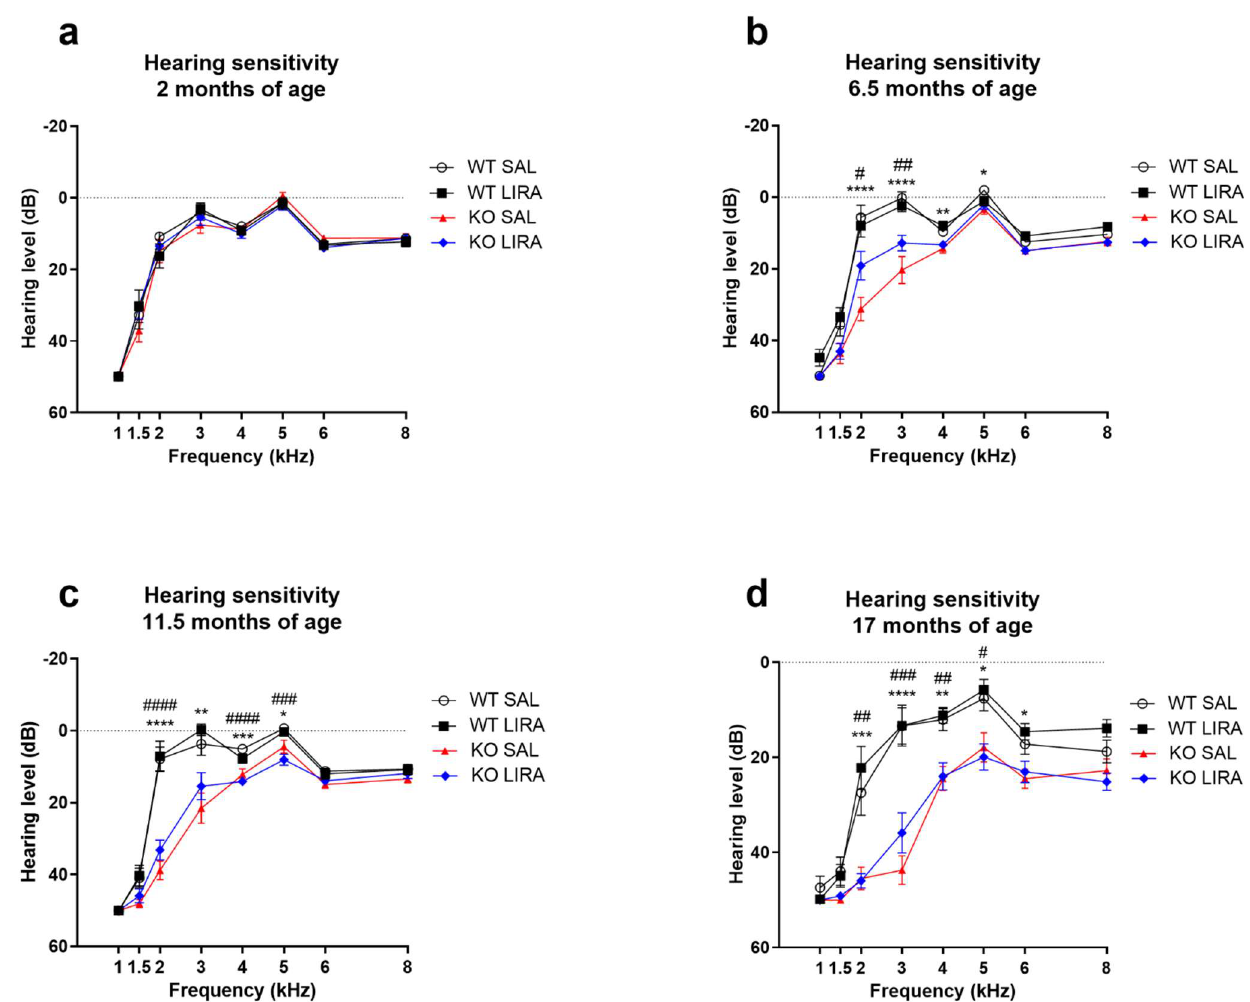
Figure 3. At the age of 6.5 months, hearing sensitivity of Wfs1 KO rats starts to decline in the range of 2 to 4 kHz and liraglutide treatment delays the decline of hearing sensitivity. Hearing sensitivity was measured for both ears and the data were averaged. Hearing sensitivity at ( a ) 2; ( b ) 6.5; ( c ) 11.5 and ( d ) 17 months of age. ( a ) At the age of 2 months, hearing sensitivity is similar for all animals regardless of treatment group and genotype. ( b ) At the age of 6.5 months hearing sensitivity of Wfs1 KO rats starts to decline in the range of 2 to 4 kHz, this decline is further exacerbated at the age of ( c ) 11.5 months and ( d ) 17 months. ( b ) Liraglutide delays the decline of hearing sensitivity. However, liraglutide treatment does not prevent the decline of hearing sensitivity in older Wfs1 KO rats ( c , d ). The data were compared using one-way ANOVA followed by Tukey’s HSD tests. The data are presented as the mean ± SEM. Significance was measured between genotype and treatment. * p < 0.05, ** p < 0.01, *** p < 0.001, **** p < 0.0001 WT SAL compared to KO SAL, # p < 0.05, ## p < 0.01, ### p < 0.001, #### p < 0.0001 WT SAL compared to KO LIRA, n = 15−26.